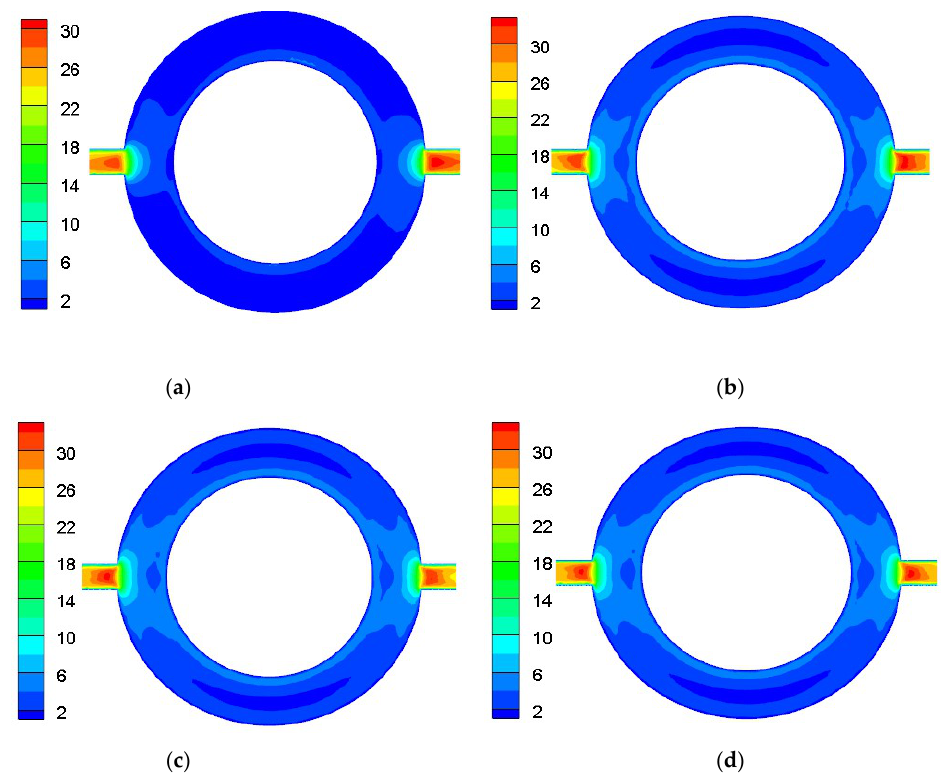
Figure 5. The velocity (m/s) distribution of air at different time when the air inflow is 12 g/s, oil inflow is 15 g/s, and the initial oil droplet diameter is 28 μm at z = 0 plane (the far left is vent; the far right is scavenge). ( a ) t = 50 ms; ( b ) t = 100 ms; ( c ) t = 200 ms; ( d ) t = 400 ms.